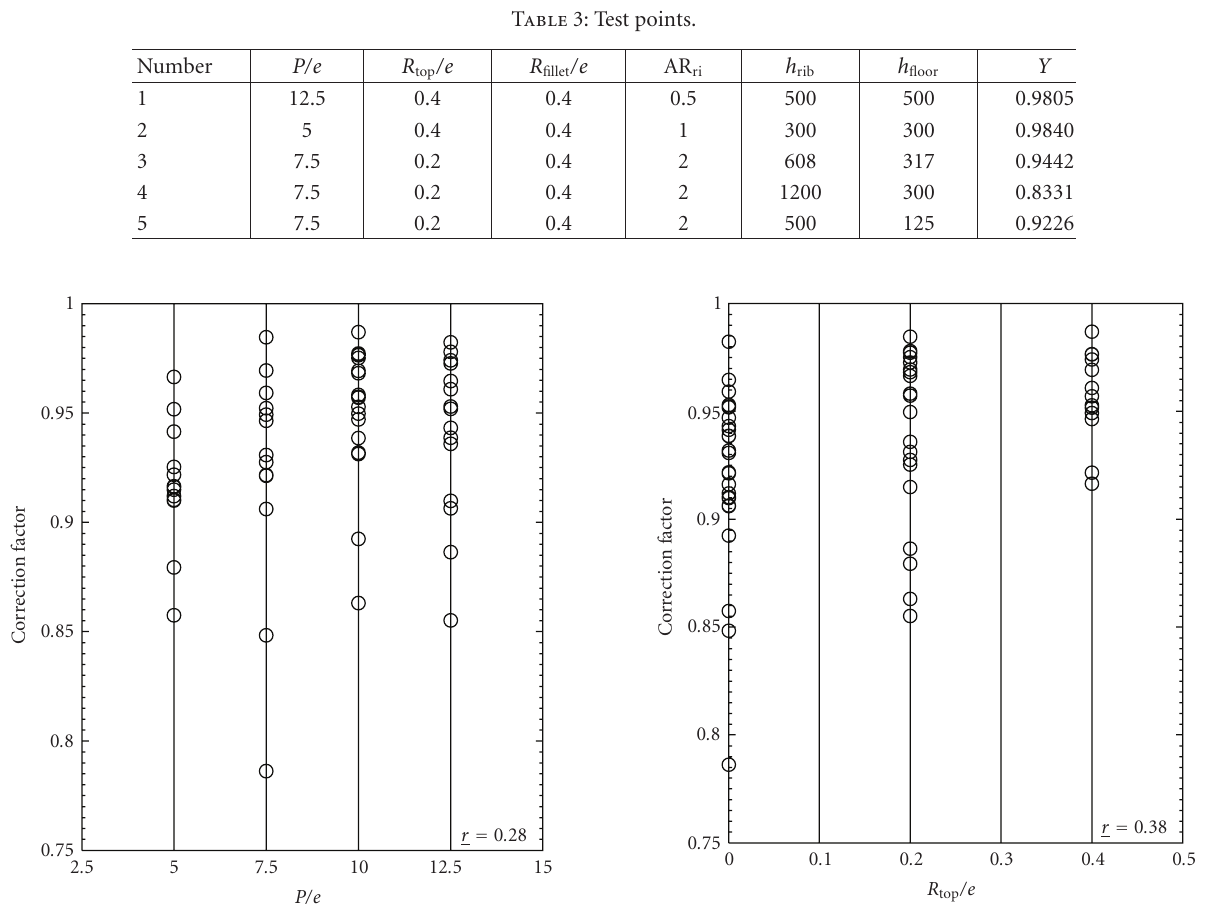
Figure 9: Correction factor variation with R top /e for the set of cho- sen